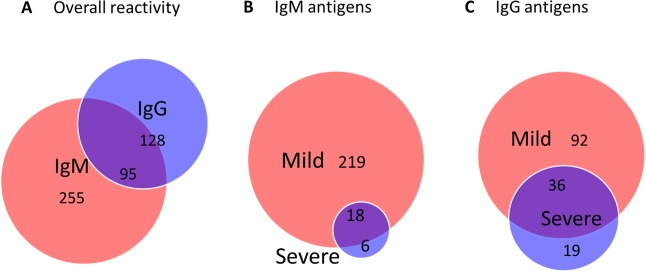
Overall IgM and IgG antibody recognition of leptospiral proteins.(A) Venn diagrams of IgM and IgG leptospiral proteins recognized by humans. Overlap of IgM (B) or IgG (C) sero-reactive antigens identified in patients with mild and severe leptospirosis.